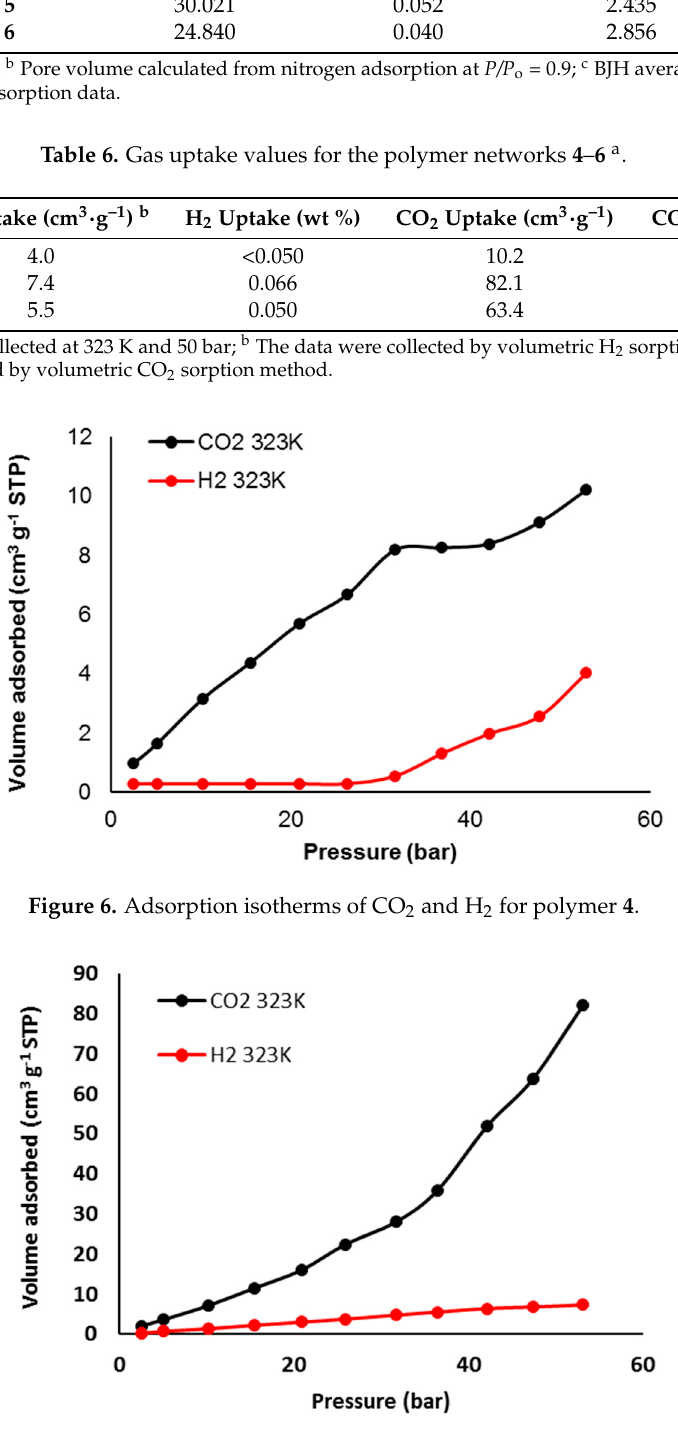
Figure 7. Adsorption isotherms of CO 2 and H 2 for polymer 5 .